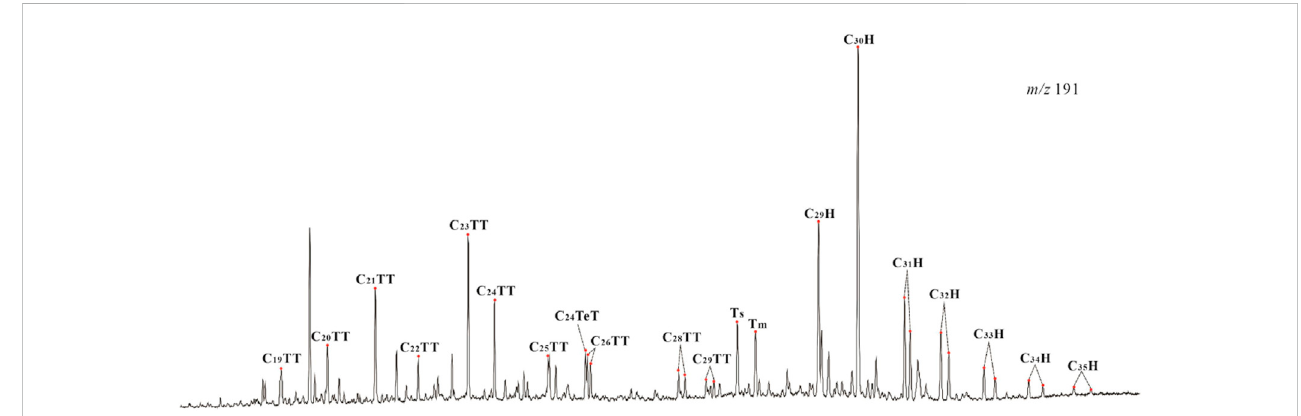
FIGURE 1 Mass chromatogram( m/z 191) showing thedistributionof tricyclic terpanes(TTs) and hopanes (Hs) intherock extract fromC1 well intheEastChina Sea